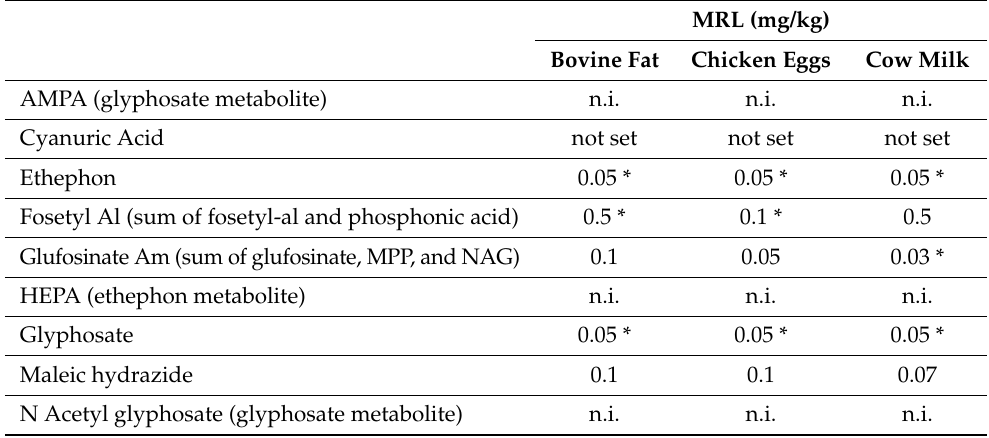
Table 1. MRL (mg/kg) of studied pesticides in bovine fat, chicken eggs, cow milk. MRL (mg/kg) Bovine Fat Chicken Eggs Cow Milk AMPA (glyphosate metabolite) n.i. n.i. n.i. Cyanuric Acid not